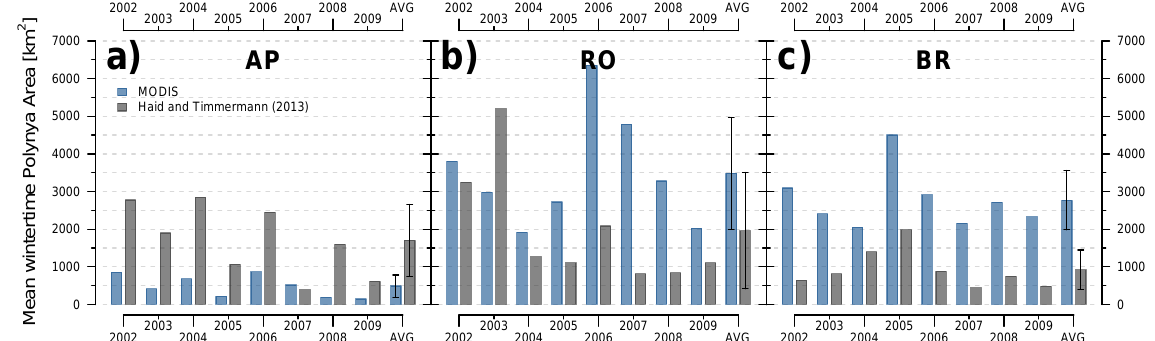
Figure 11. Average wintertime (May to September) polynya area (POLA, km 2 ). Shown is a comparison between our results (blue) and the model results from Haid and Timmermann (2013) (grey) for the years from 2002 to 2009 as well as the multi-year average (AVG) ± 1 standard deviation (error bars).